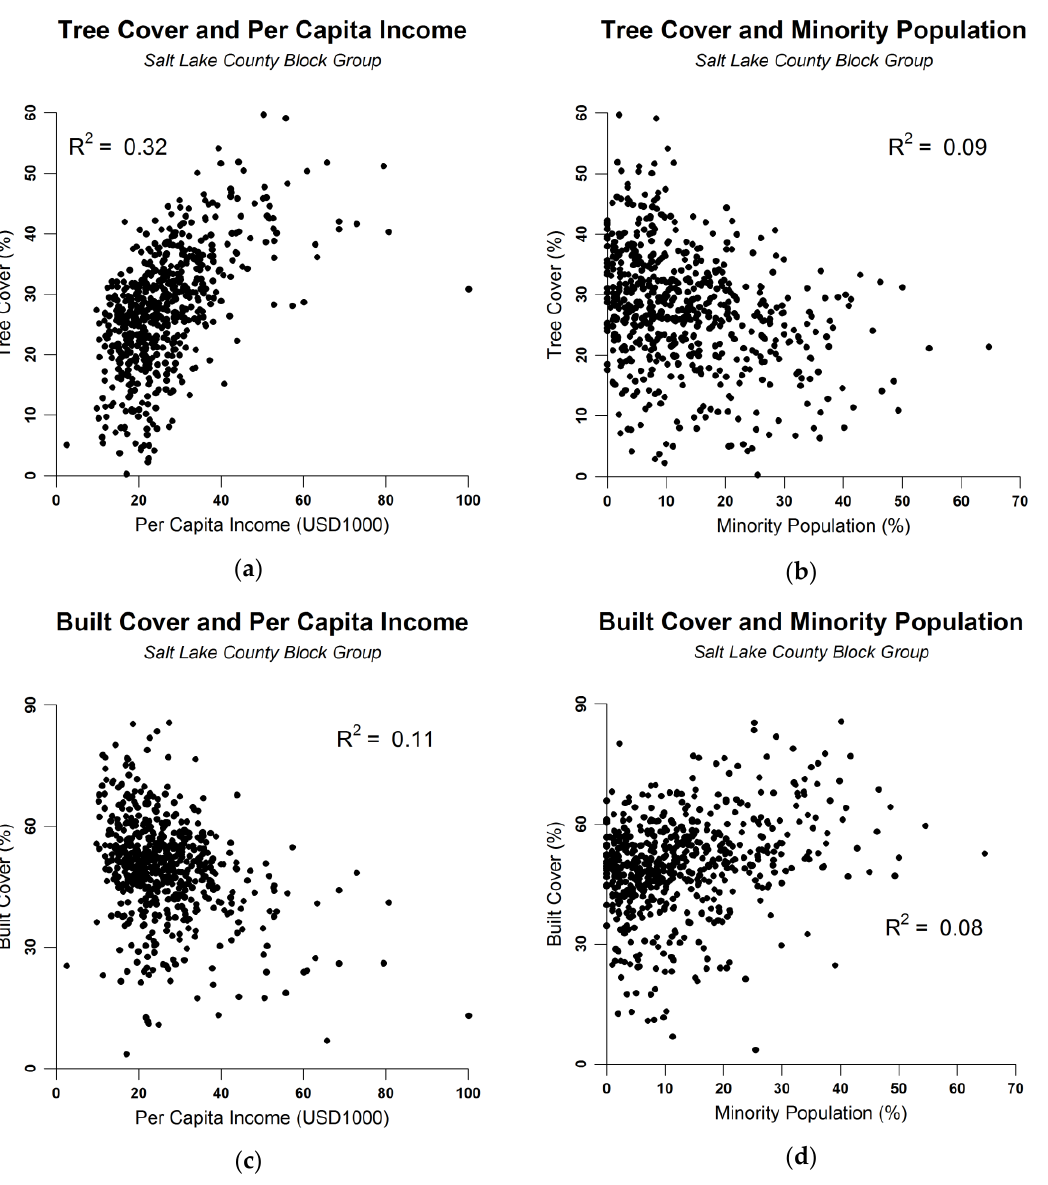
Figure 4. Sociodemographic distribution of various land cover categories at the block group level: ( a ) Tree cover and per capita income; ( b ) Tree cover and minority population; ( c ) Built cover and per capita income; and ( d ) Built cover and minority population.